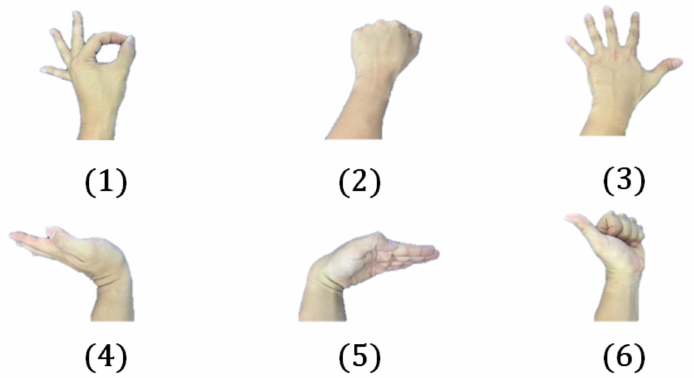
Figure 14. The six gestures defined in this